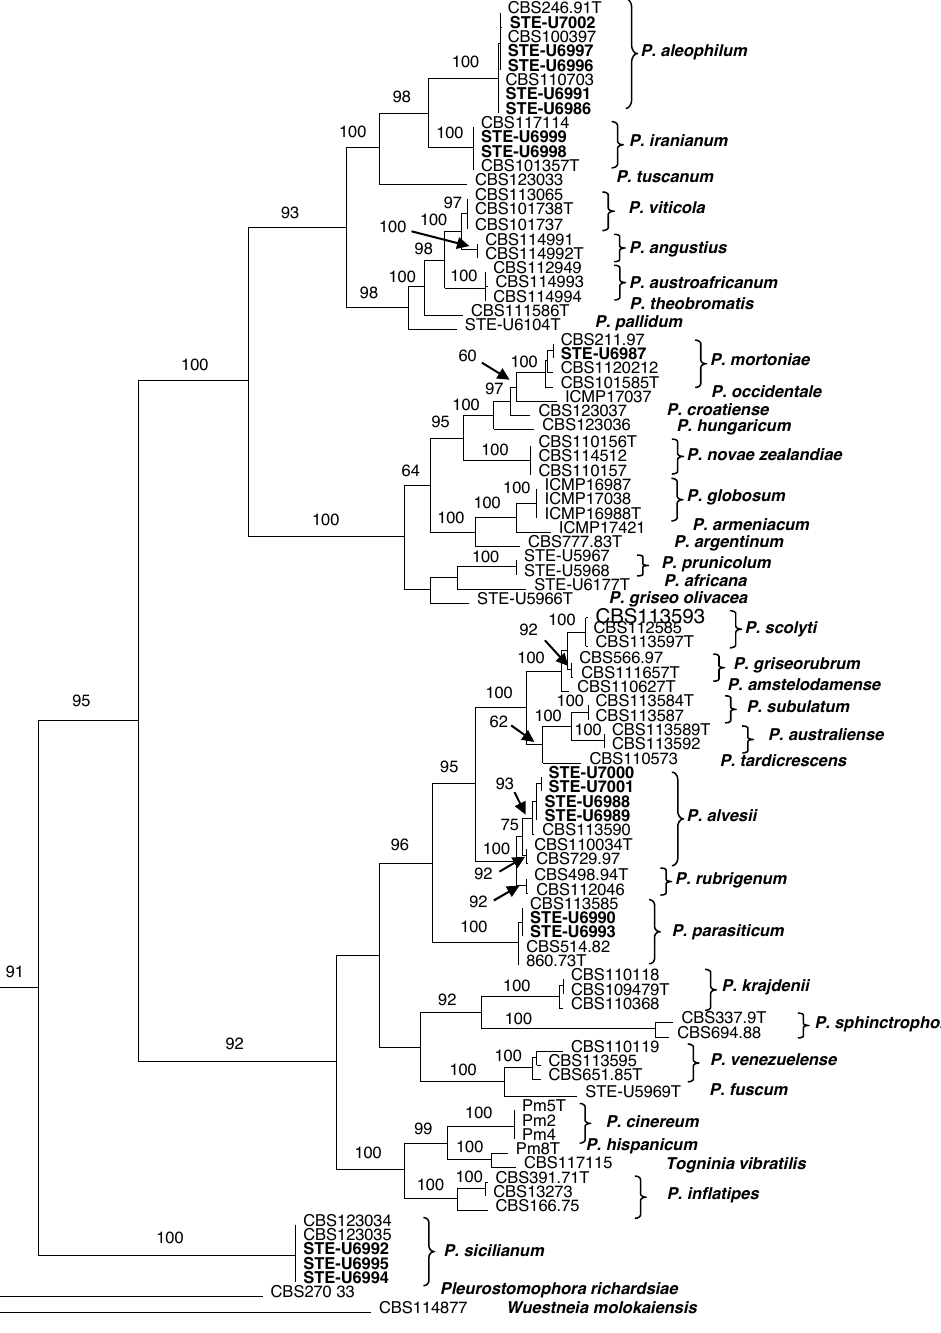
Figure 1. One of 100 most parsimonious trees obtained from heuristic searches of the combined β -tubulin and actin sequences (length: 2621steps; CI: 0.473; RI: 0.858; RC: 0.406) of Phaeoacremonium isolates. Bootstrap support values above 60% are shown above the nodes. The outgroups were Pleurostomophora richardsiae and Wuestneia molokaien- sis . Isolates in bold print are from this